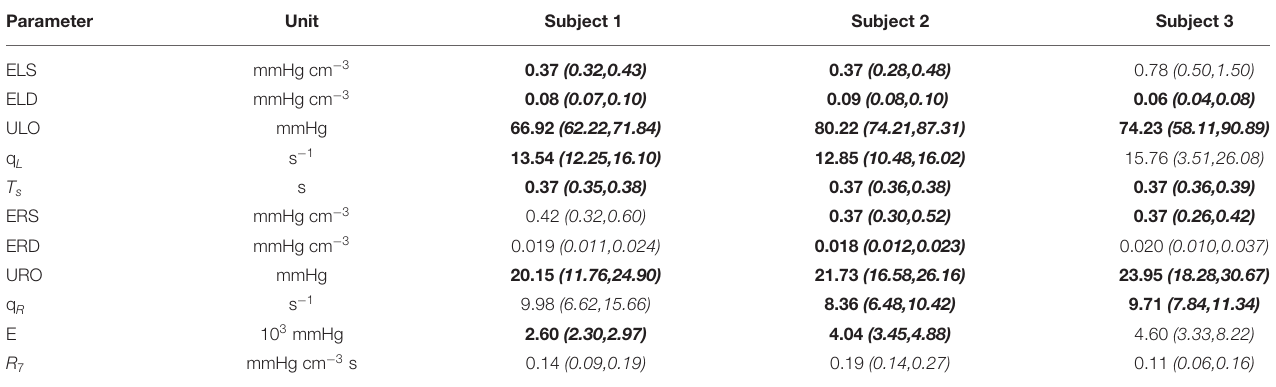
TABLE 7 | Summary of EA estimated parameters for the three subjects involved in the study.